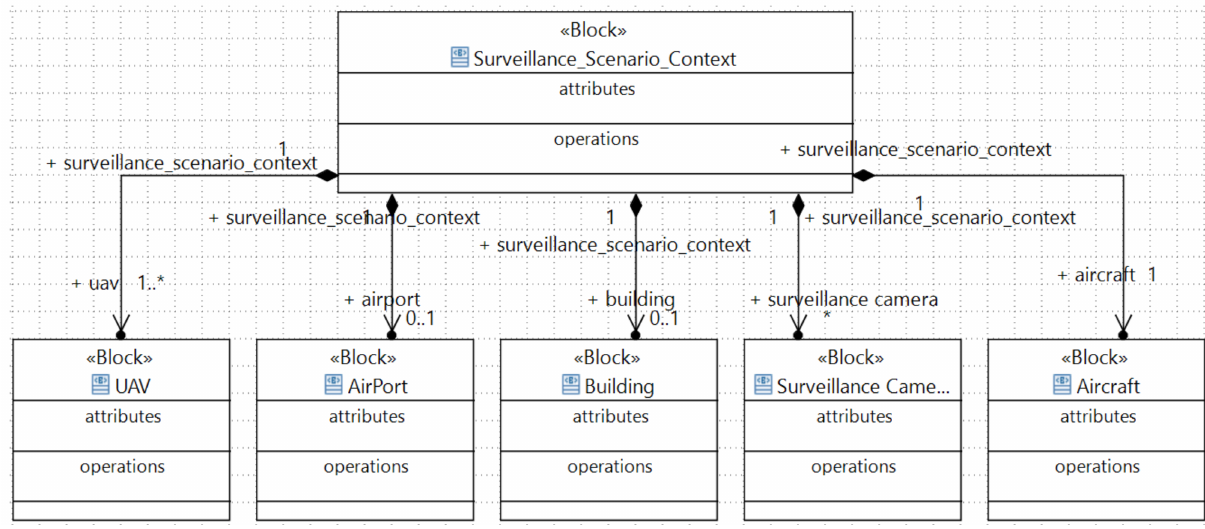
Figure 6. Scenario context